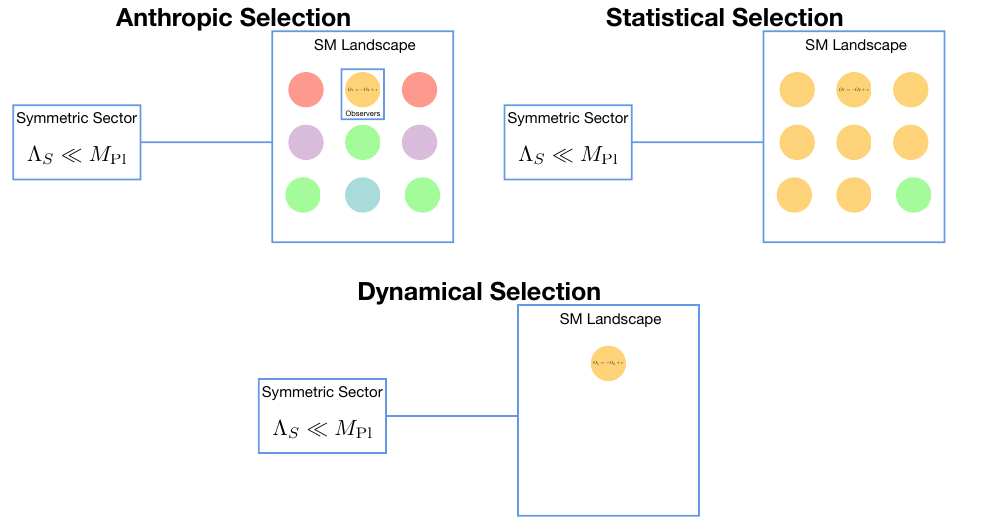
Figure 2 . Models of cosmological selection of the weak scale. Anthropic selection (upper left panel), Statistical selection (upper right panel) and Dynamical selection (lower panel) are distinguished by the structure of the landscape at late times. In the anthropic case the landscape contains all values of m 2 with no preference for h h i ’ v . In the statistical case h h i ’ v dominates Multiverse according h to some measure, but also all other values are present. In the dynamical case only universes with h h i ’ v are cosmologically long-lived and non-empty.